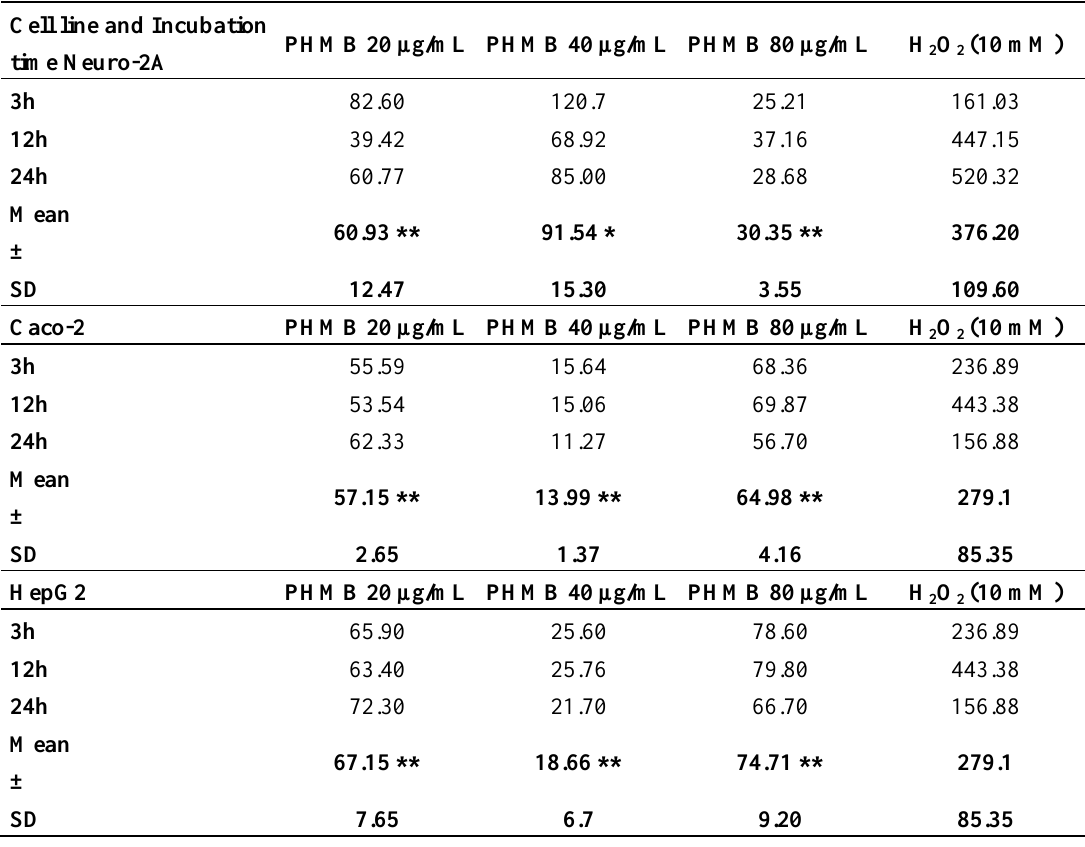
Table 4. Effect of PHMB (20–80 µg/mL) on MDA production (pmol/mg of protein) in Neuro-2A, Caco-2 and HepG2 cell lines . Cells were incubated with PHMB or H (positive control) for 3 h, 12 h and 24